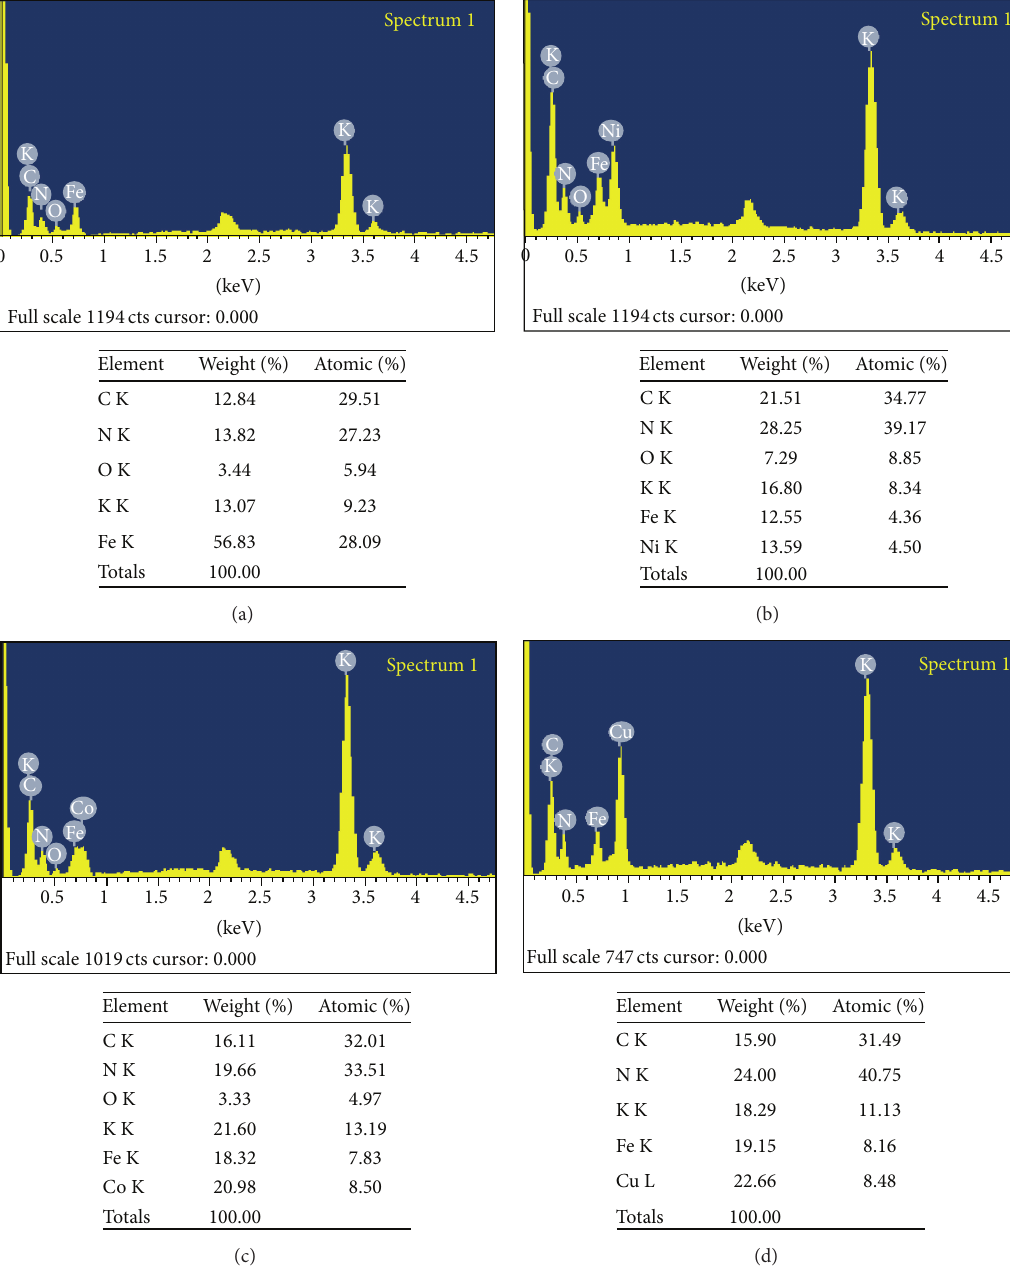
Material available online at http://dx.doi.org/10.1155/2016/